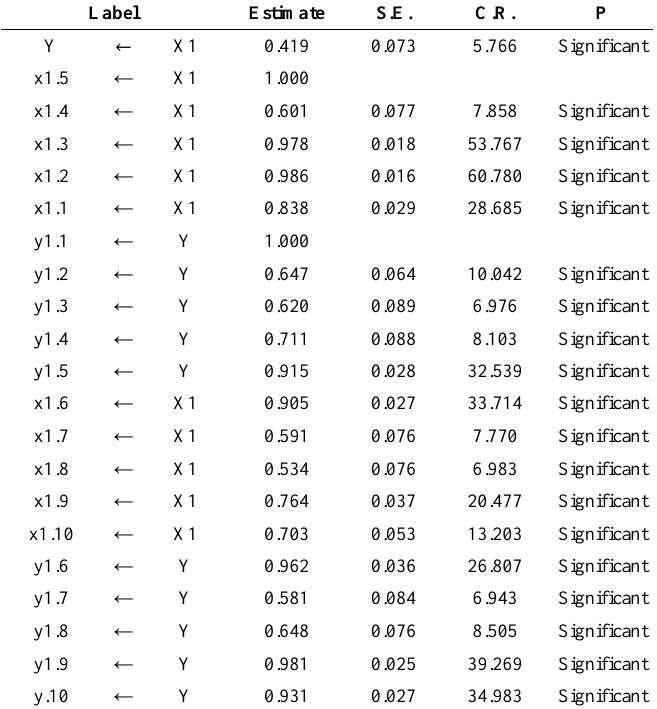
Table 3. Results of Indicator Validity (IV) and CR Tests of Leadership Exogenous Variables Label